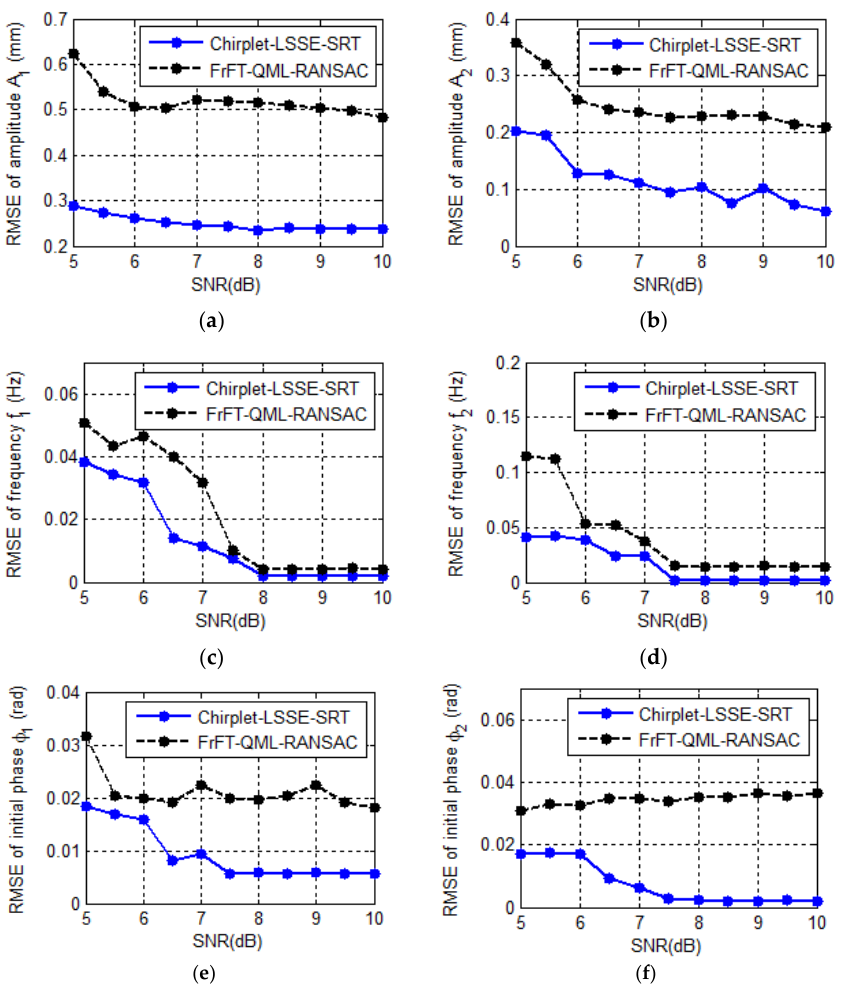
Figure 11. RMSE in different SNRs. ( a ) Amplitude A 1 ; ( b ) amplitude A 2 ; ( c ) frequency f 1 ; ( d ) frequency f 2 ; ( e ) initial phase ϕ 1 ; ( f ) initial phase ϕ 2 .